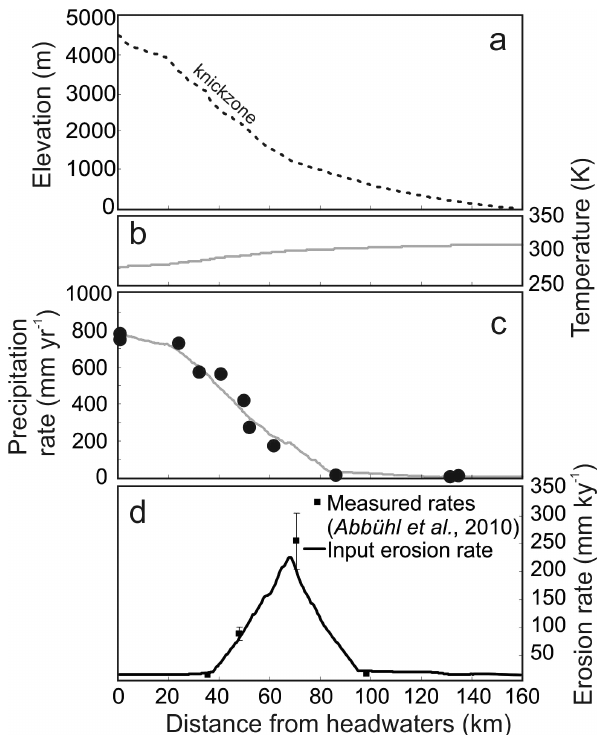
Figure 2. Geomorphic and climatic input parameters along the Pisco river including (a) river longitudinal profile, (b) temperature, (c) annual precipitation, and (d) erosion rate. Input rainfall stations (Agteca, 2010) projecting along strike onto the Pisco river profile are shown by filled circles; input erosion rates with errors (Abbühl et al., 2011) are shown by filled squares. Downstream erosion rates were estimated by spatially interpolating the erosion rate data of Abbühl et al. (2011) and extracting the long